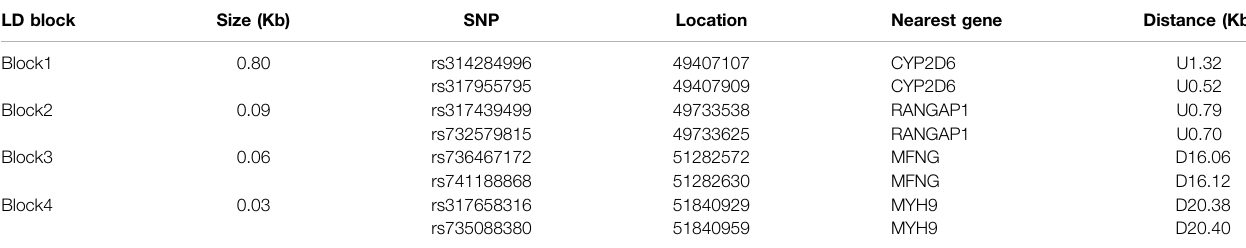
TABLE 2 | Signi fi cant SNPs in the LD Block.